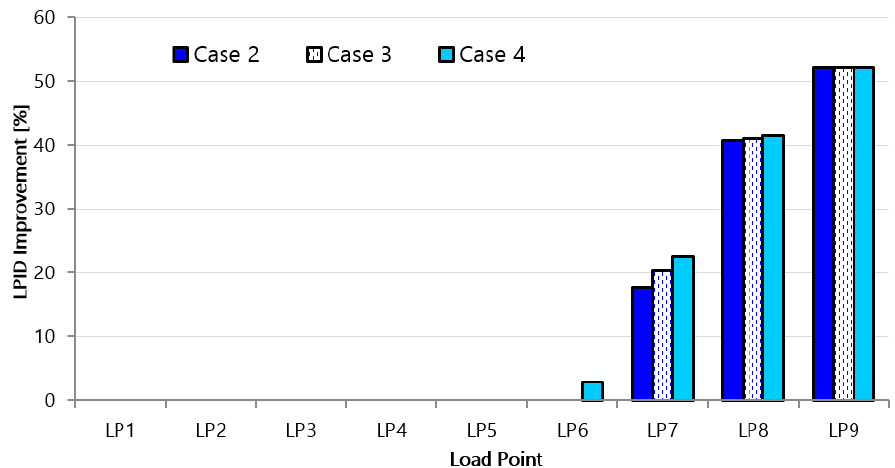
Figure 5. LPID improvement in load points for case studies compared to Case-1.